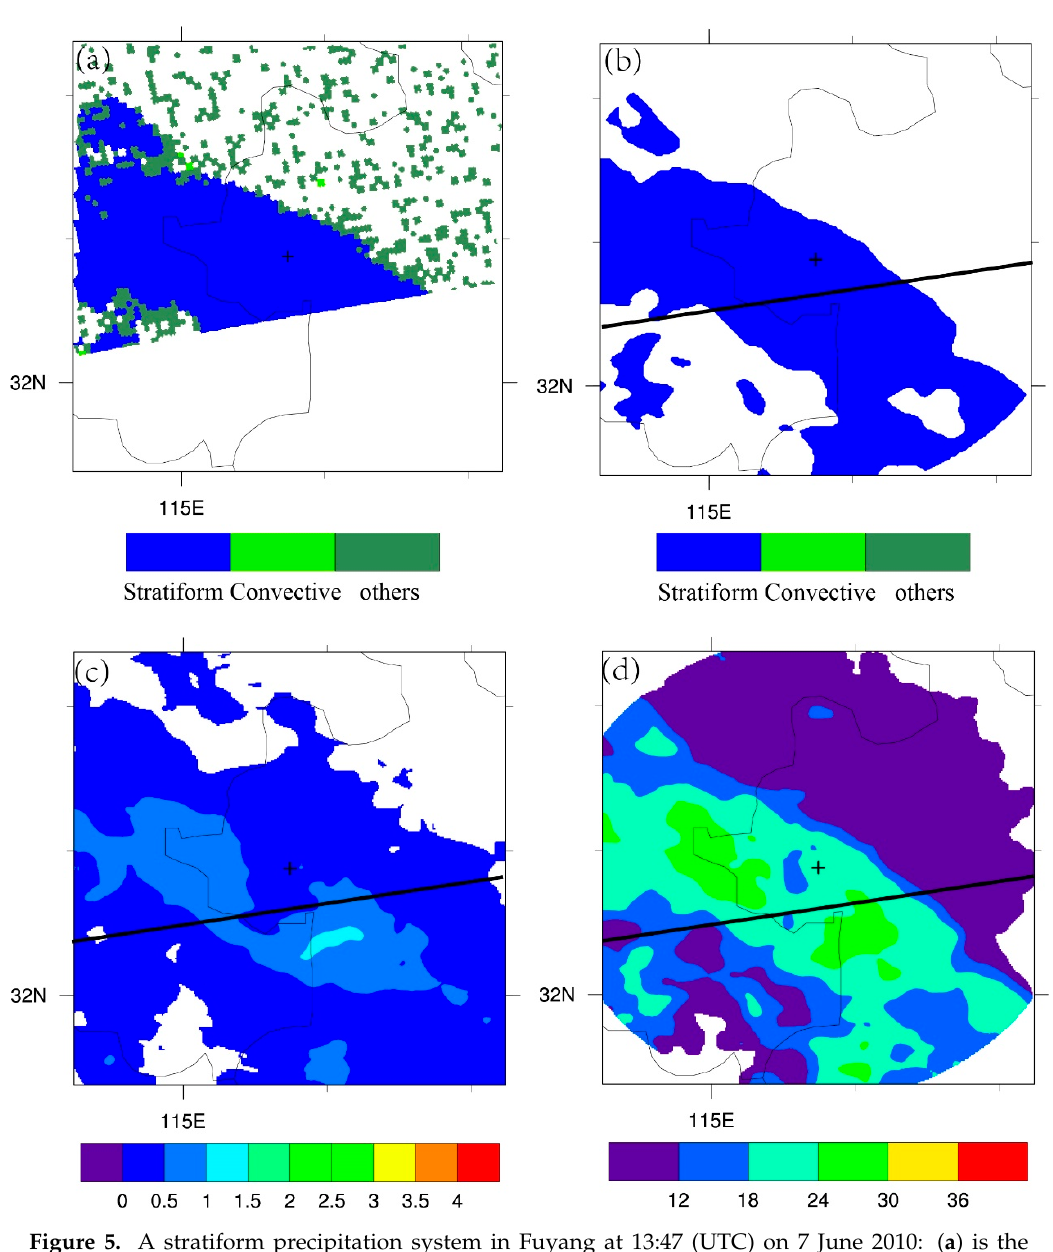
Figure 5. A stratiform precipitation system in Fuyang at 13:47 (UTC) on 7 June 2010: ( a ) is the classification of the 2A23 product, ( b ) is the KNN classification, ( c ) is VIL, and ( d ) is ref2km. The bold black line represents the boundary of the PR scan range.